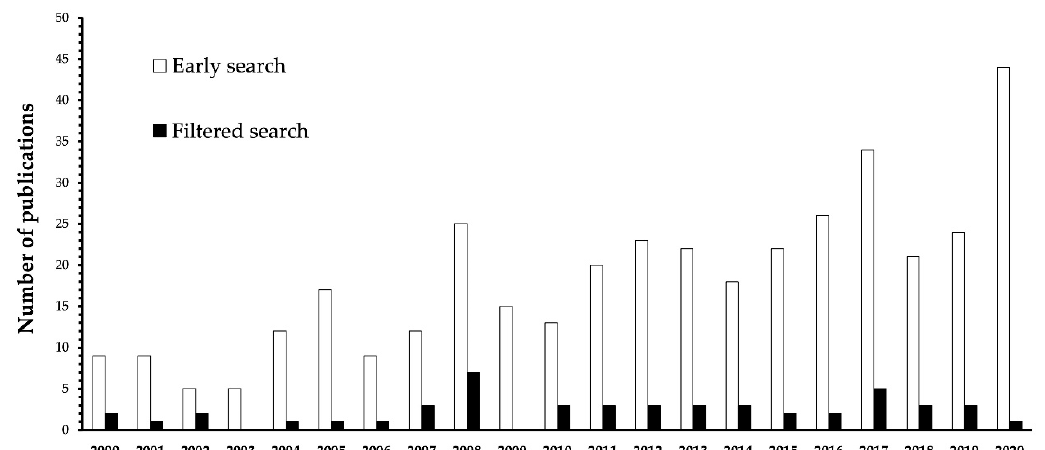
Figure 3. Number of articles published by years on the topic. White bars show the raw results found in the initial databases search, and black bars the final selection included in this review.